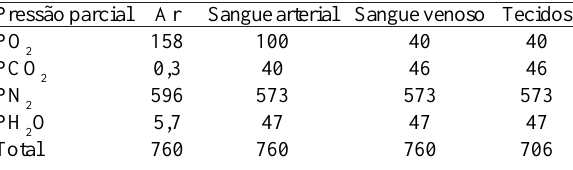
e SaO após a mistura com sangue 2 2